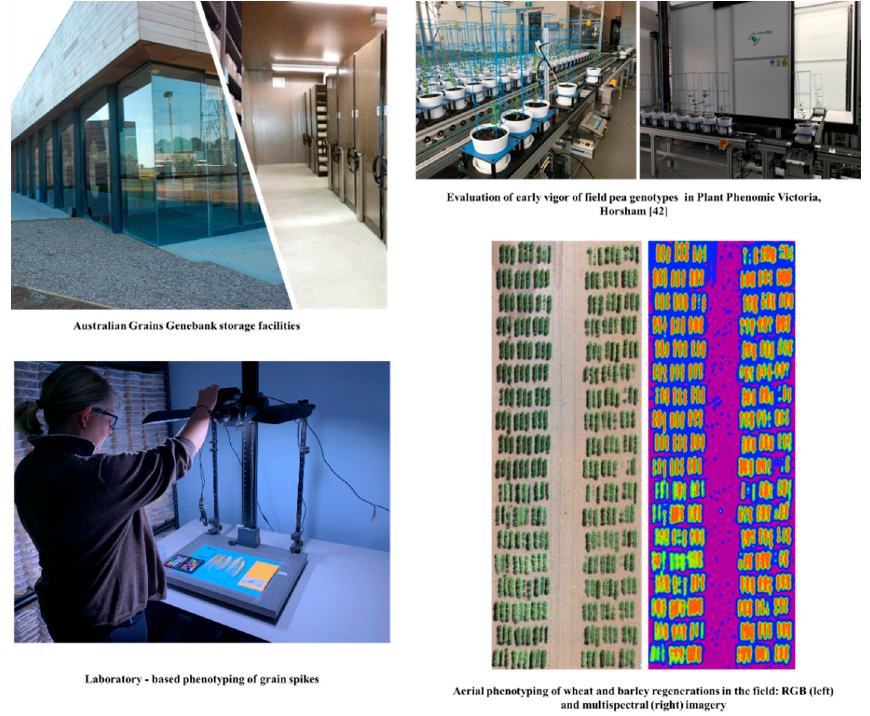
Figure 2. Australian grains genebank (AGG) storage facilities and its application of HTP technology for phenotyping routine seed regenerations in laboratory, greenhouse and field.